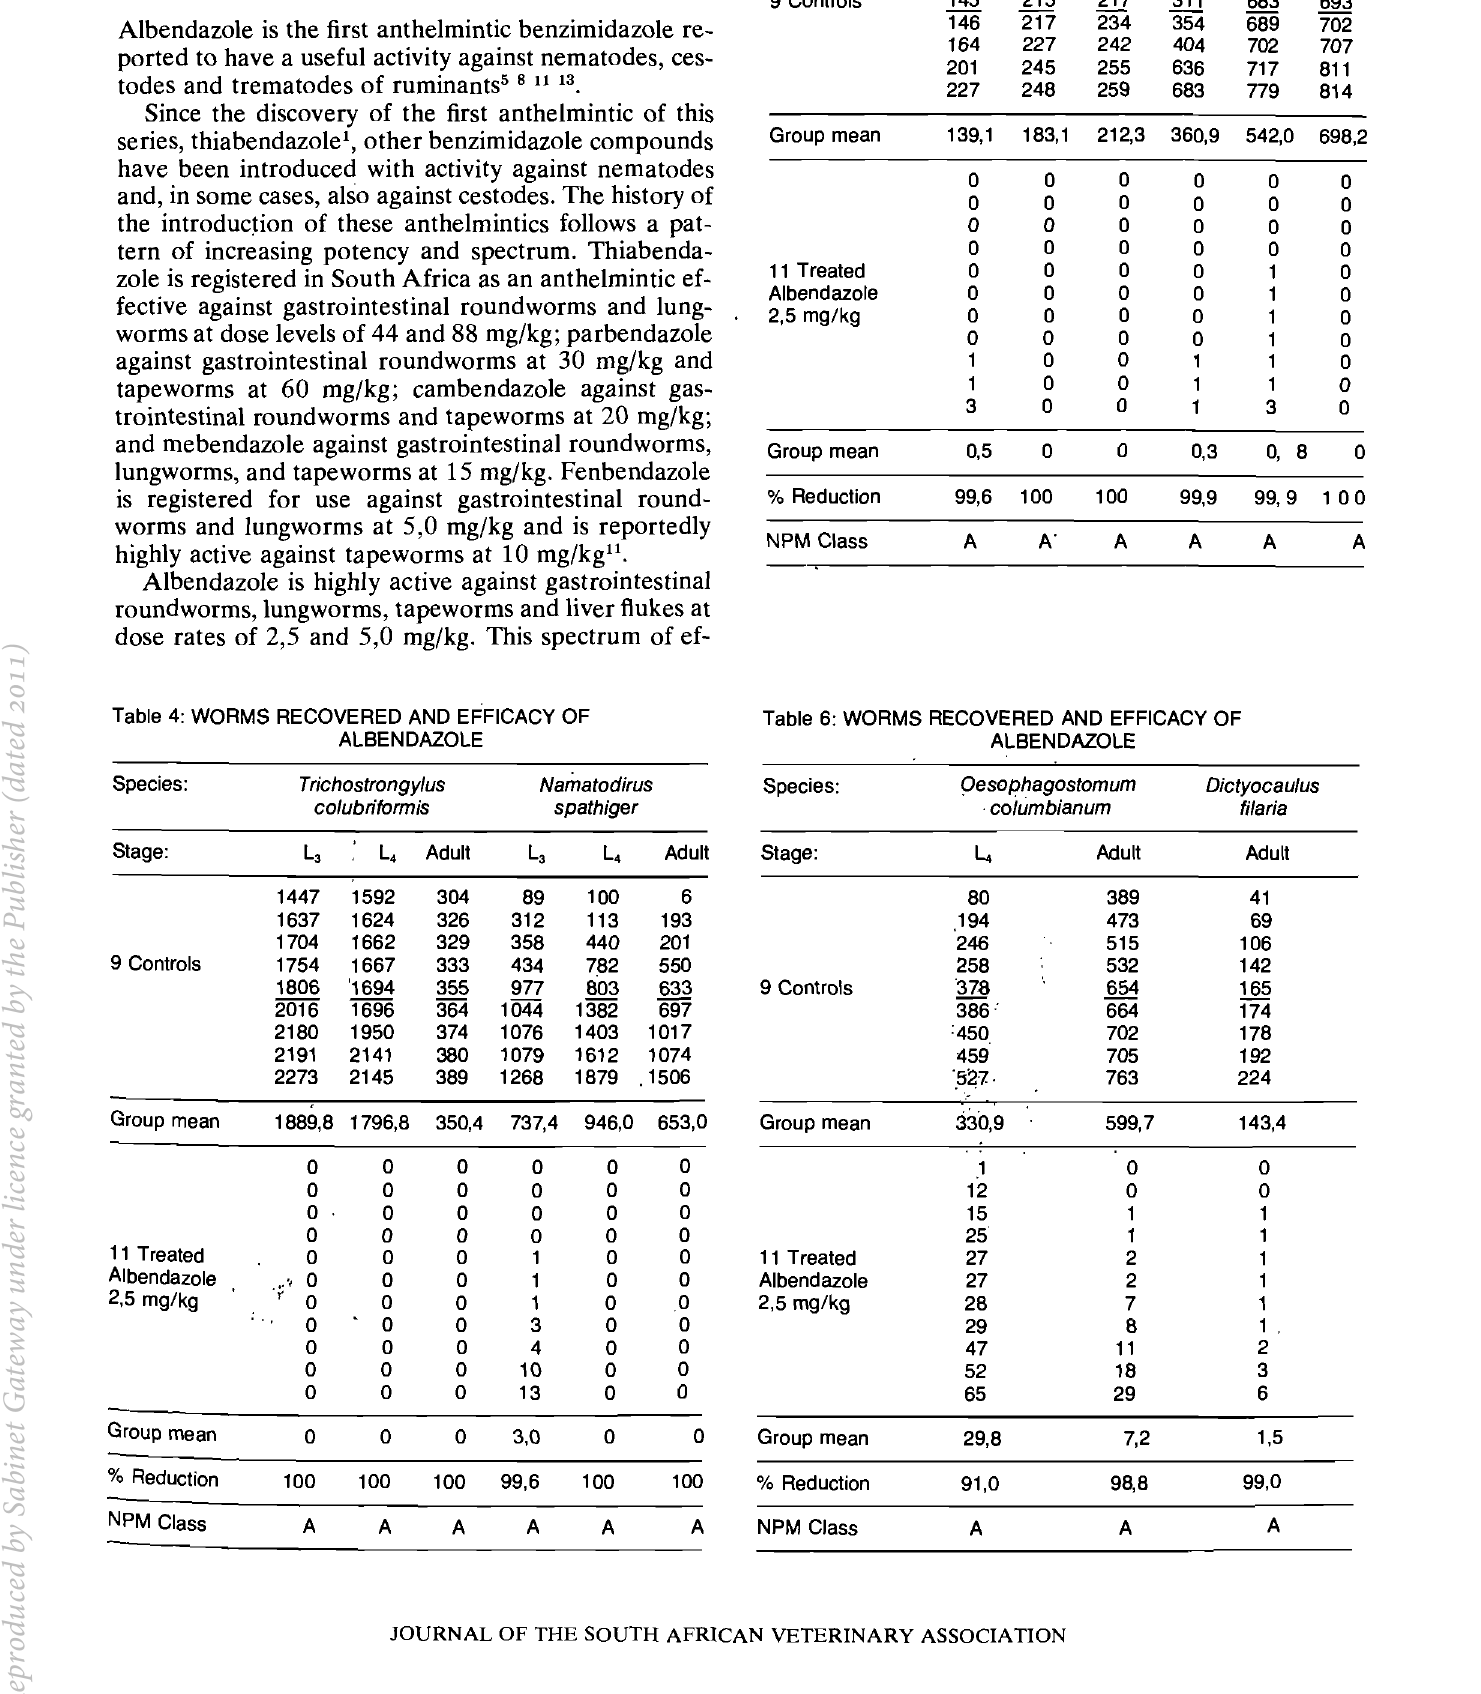
Table 5: WORMS RECOVERED AND EFFICACY OF